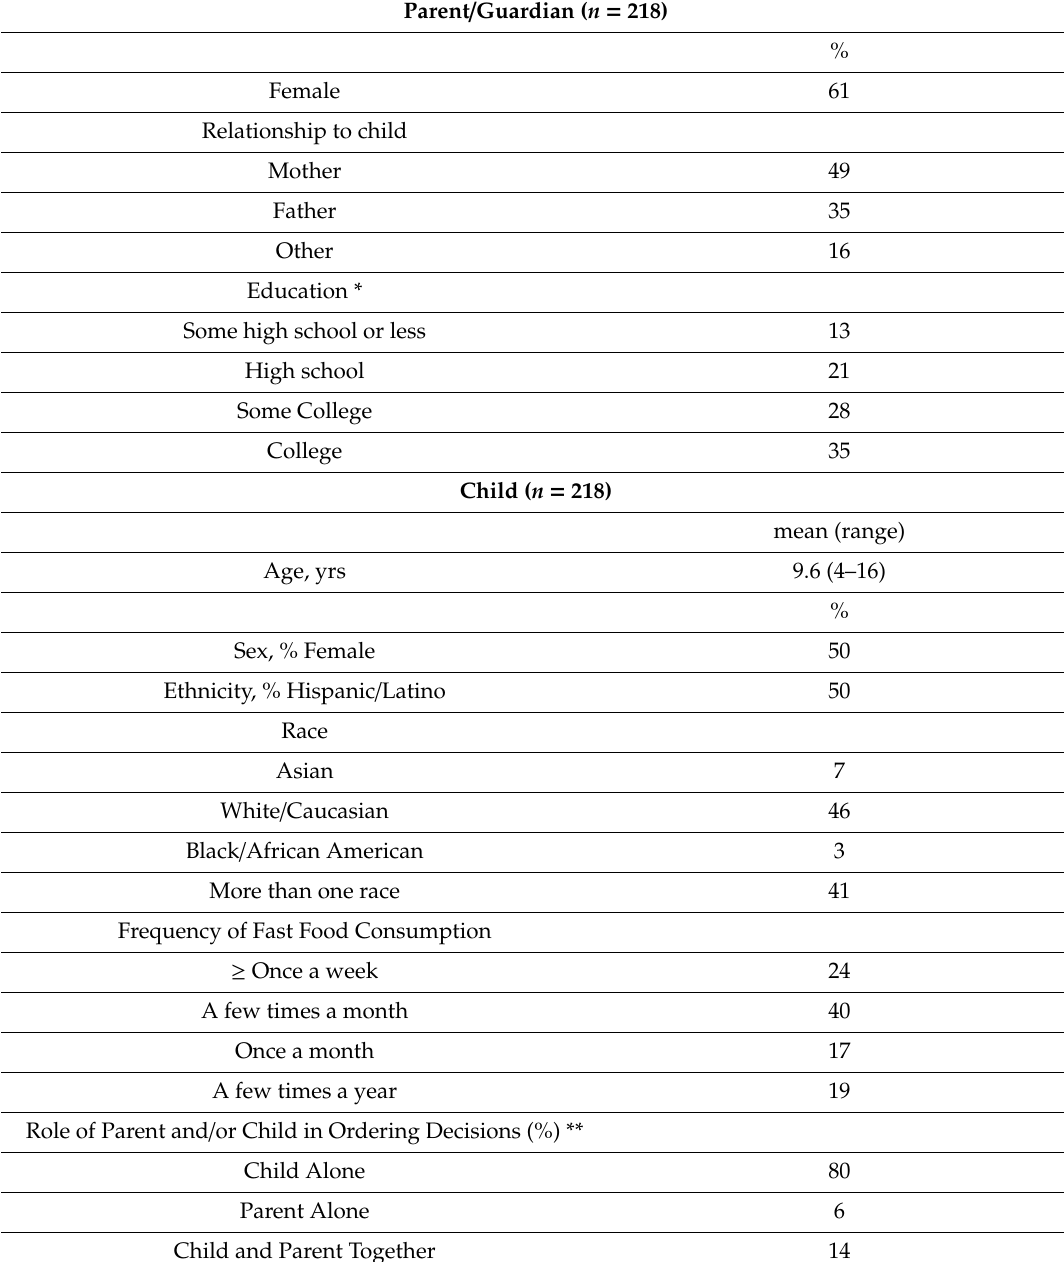
Table 1. Participant characteristics of parents and children ordering meals in